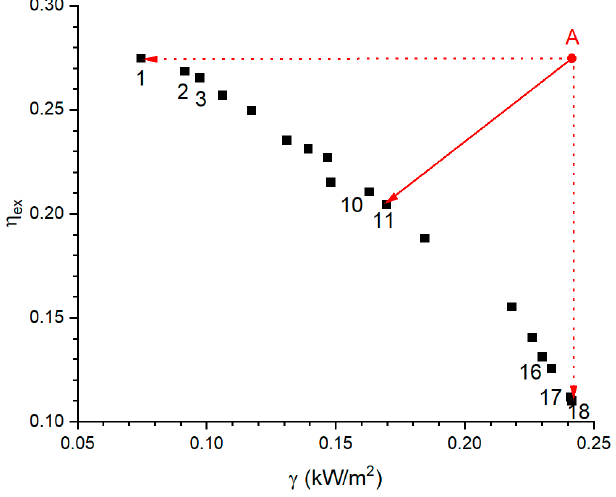
Figure 4. The results of the multi-objective optimization.